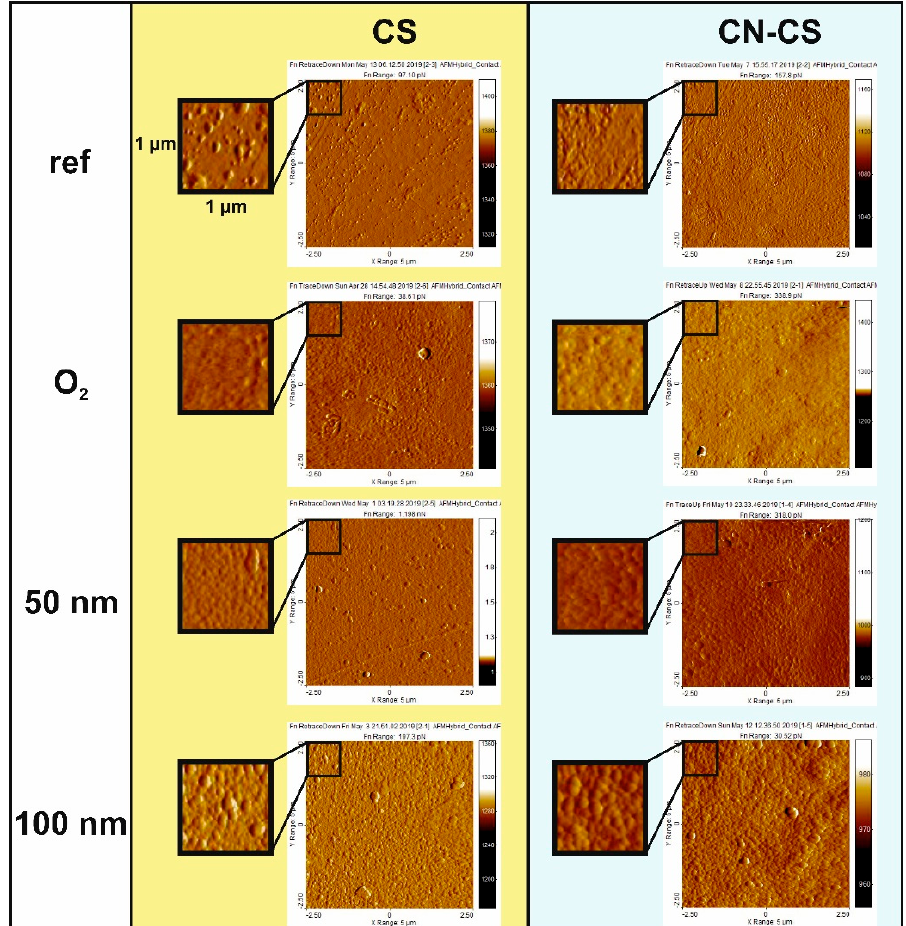
Figure 3. Atomic force microscopy (AFM) images for the surface of neat CS (left) and CN–CS (right) films. Results for the untreated and O 2 plasma treated polymer and the 50 nm and 100 nm a–C:H coatings are shown top down.